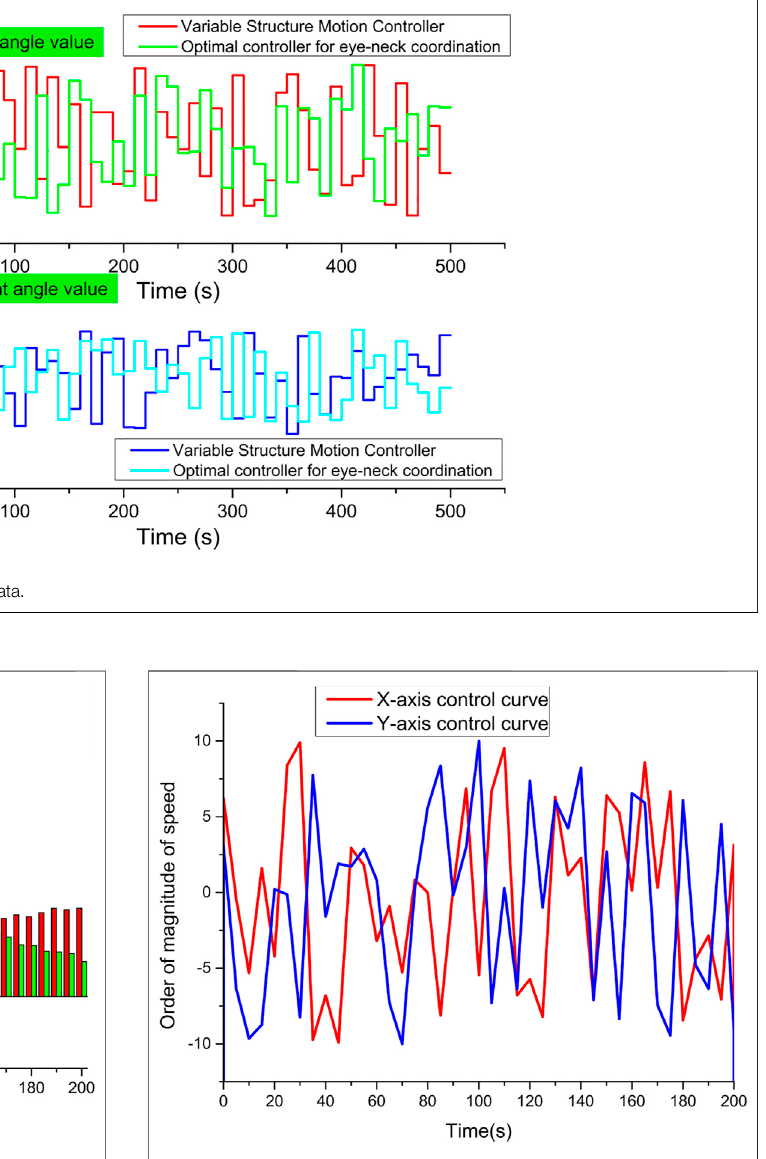
FIGURE 7 | The effect of uniform motion target tracking.